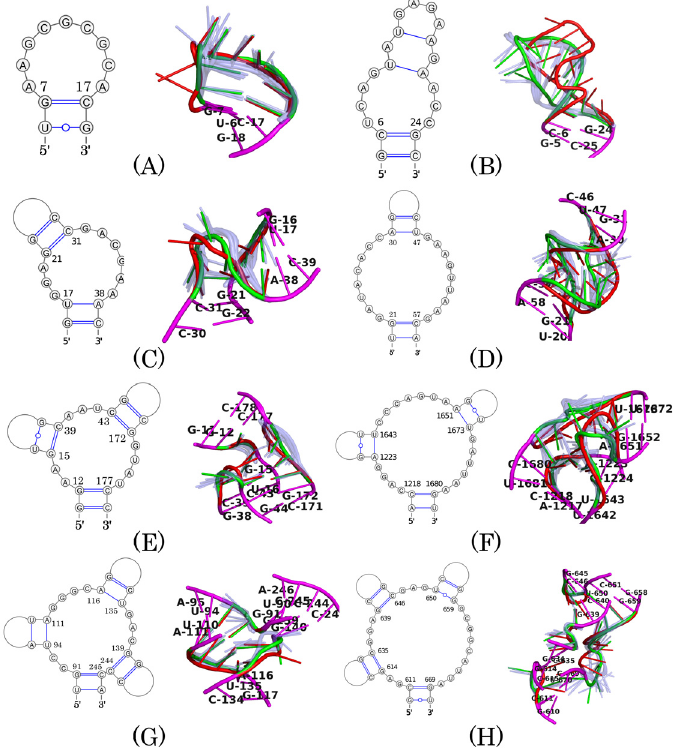
Fig 8. Superposition of the predicted and the experimental structures for four types of loops. The experimental structures are colored red, the predicted loops are green, and the first 20 structures in the largest cluster are colored light-blue and semi-transparent. The anchor nucleotides are colored magenta. (A) to (H) correspond to the data points of the same labels shown in Fig 7. (A)(B) are hairpin loops, (C)(D) internal loops, (E)(F) three-way junction loops, (G)(H) four-way junction loops. The loop length and RMSD are as follows: (A) 9 nt and 4.21 Å , (B) 17 nt and 6.46 Å , (C) 9 nt and 3.81 Å , (D) 17 nt and 3.76 Å , (E) 9 nt and 4.51 Å , (F) 17 nt and 4.34 Å , (G) 9 nt and 3.96 Å , (H) 17 nt and 5.17 Å